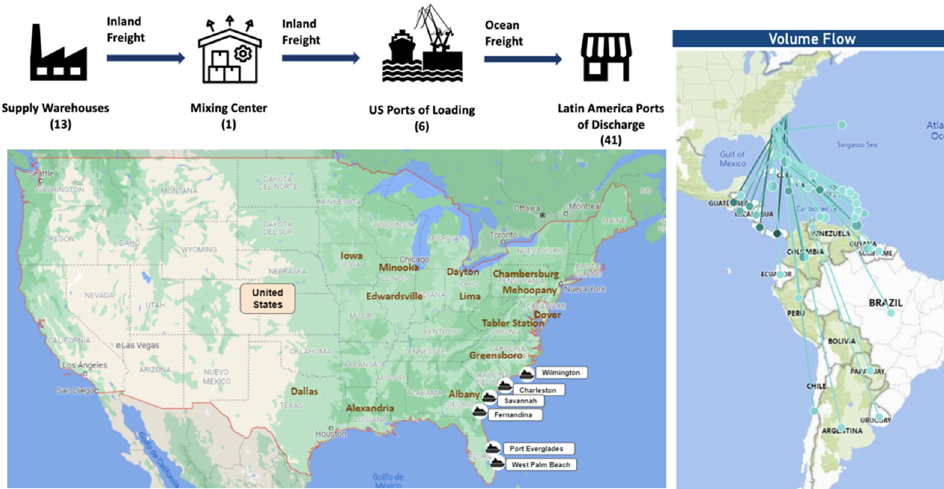
Figure 1. Current supply chain network, ports’ location, and current flow allocation from the US ports to Latin American customers.